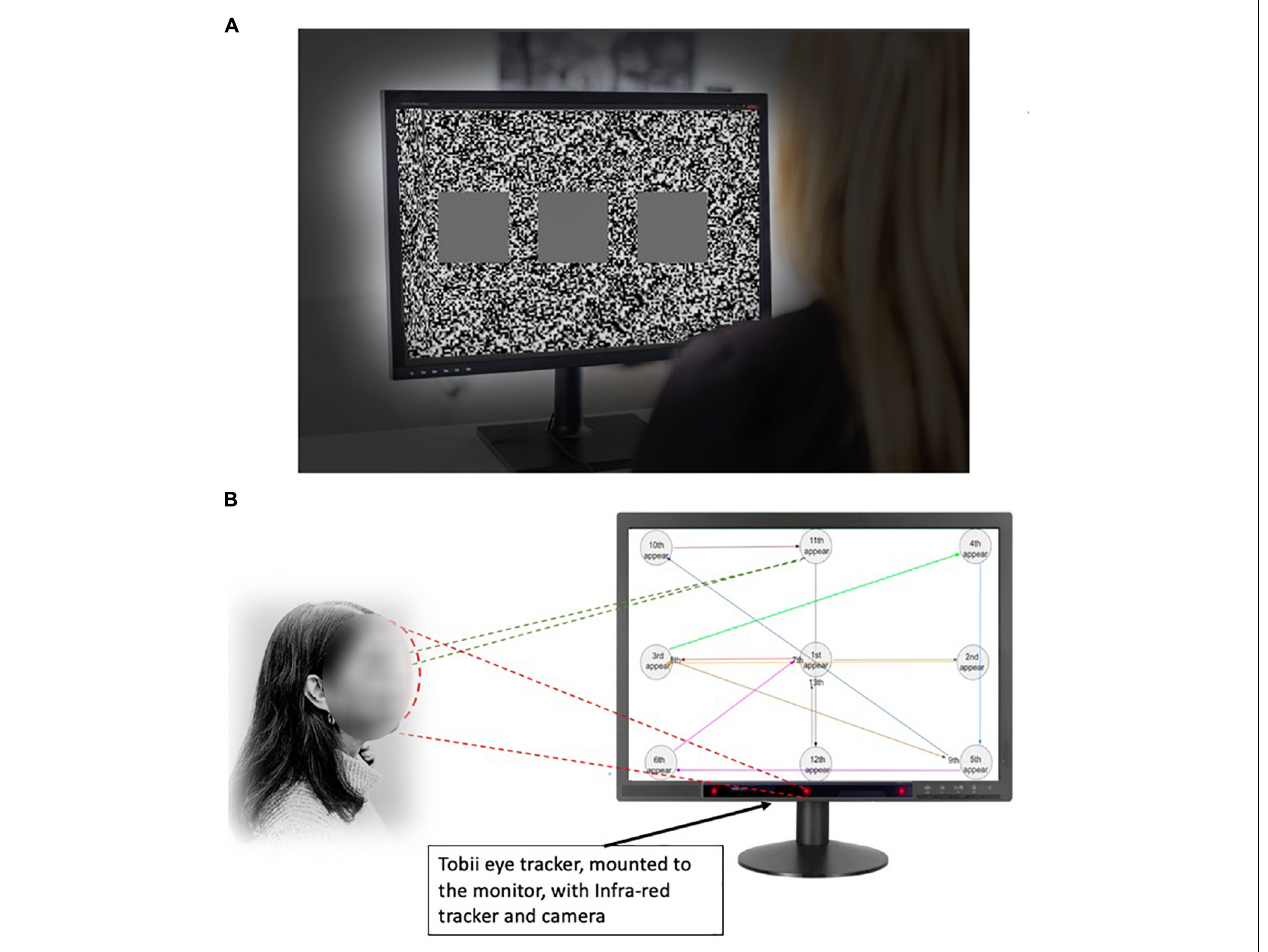
FIGURE 1 | Experimental settings to evaluate stereopsis with the 3D monitor active shutter system. (A) The 3D monitor active shutter system. The visual stimuli were presented on a 3D monitor using a 24-inch 3D video monitor. A special pair of shutter glasses containing a liquid crystal layer was used. The images were set at a refresh rate of 60 frames/s. The visual stimuli for each testing position consisted of a set of three squares, placed side-by-side placed in the foreground with a fixed white noise background. One of the squares, randomly decided, was of a one-pixel disparity while the others are presented at zero parallax. (B) The eye-tracking system. The Tobii eye tracker was installed beneath the 3D TV monitor. The gaze “hot spots” and position data can be extracted from the TV watching. The participants were asked to track a moving object with their gaze as it appeared on the screen at 13 positions in a predetermined order, and the speed of appearing/disappearing of the visual object remained the